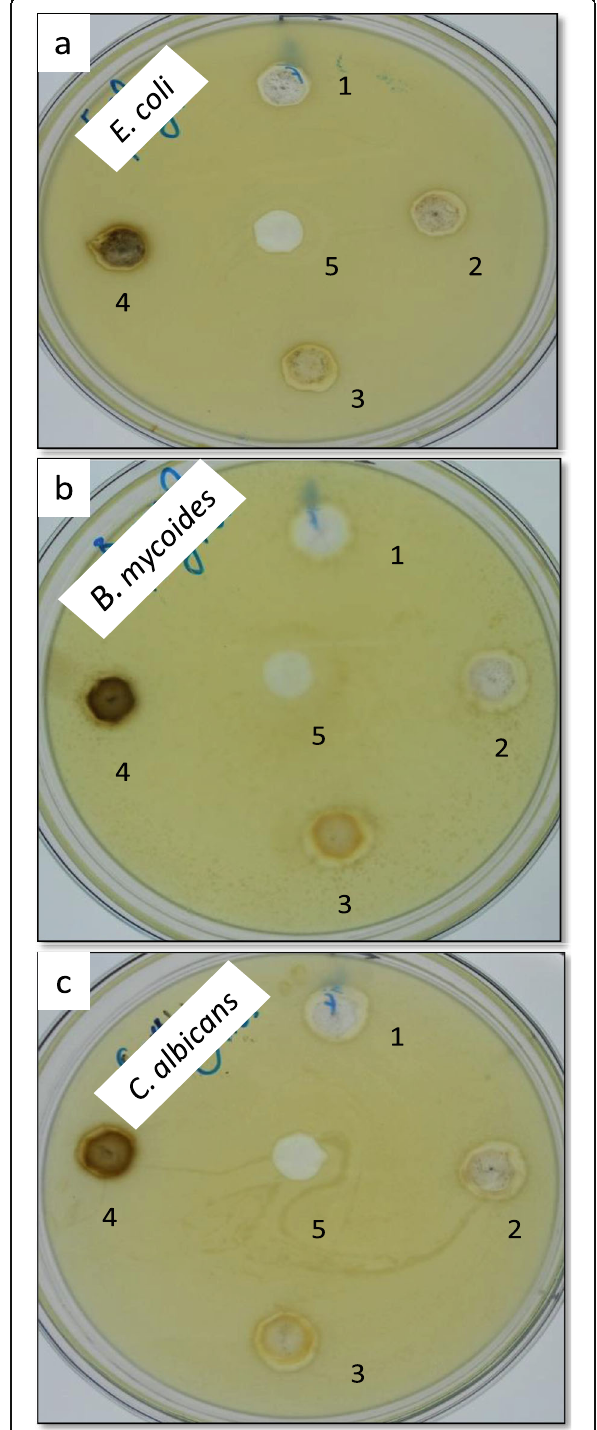
Fig. 6 Antimicrobial activity of the AgNPs biosynthesized by means of A. fumigatus CFF mediation. (1) AgNPs sample formed at pH 6.0, (2) at pH 8.0, (3) at pH 10.0, (4) at pH 12.0, and (5) cell free